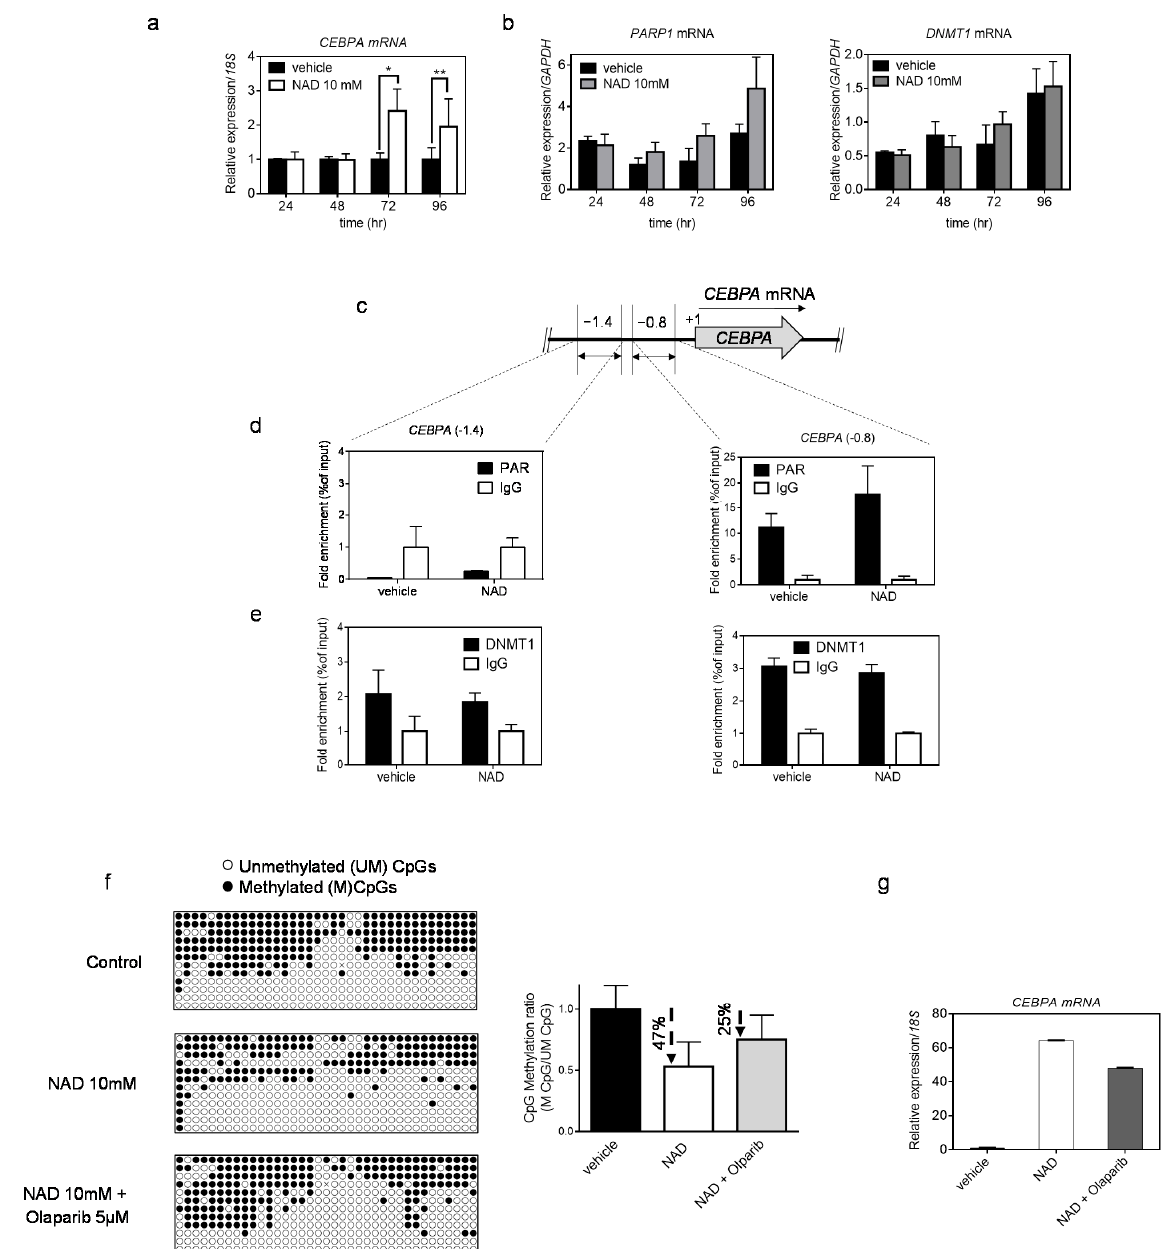
Figure 3. NAD treatment enhances CEBPA transcription in K562 by a PARP1-dependent mechanism . Panel ( a ) shows CEBPA mRNA levels after four days of treatment with NAD. qRT–PCR bars represent the mean ± s.d. of four independent experiments ( n = 4). Panel ( b ) shows PARP1 and DNMT1 mRNA levels after four days of treatment with NAD. qRT–PCR bars represent the mean ± s.d. of three independent experiments( n = 3). Chromatin was collected to perform ChIP assays with antibodies to PAR, DNMT1 and IgG ( c – e ). ( c ) Schematic of the CEBPA promoter regions screened by ChIP-qPCR analysis respectively at − 1.4 kb and − 0.8 kb from the TSS (double-headed arrows). ( d ) ChIP using PAR antibody and qPCR analysis of regions − 1.4 kb (left panel) and − 0.8 kb (right panel). ( e ) ChIP using DNMT1 antibody and qPCR analysis of regions − 1.4 kb (left panel) and − 0.8 kb (right panel). Error bars indicate ± S.D. *: p < 0.05; **: p < 0.01. ( f , g ) K562 cells were cultured in presence of + NAD 10 mM alone, Olaparib 5 µ M + NAD 10mM or vehicle. The methylation status of the distal promoter ( − 0.8 kb region) after treatment was assessed at the third day ( n = 9 clones). Lollipop graphs were generated using QUMA software. CpG methylation ratio, consisting of methylated CpGs divided by unmethylated CpGs, was calculated by QUMA software. ( g ) CEBPA mRNA levels upon NAD treatment. qRT–PCR bars indicate mean ± s.d. of three independent experiments ( n =